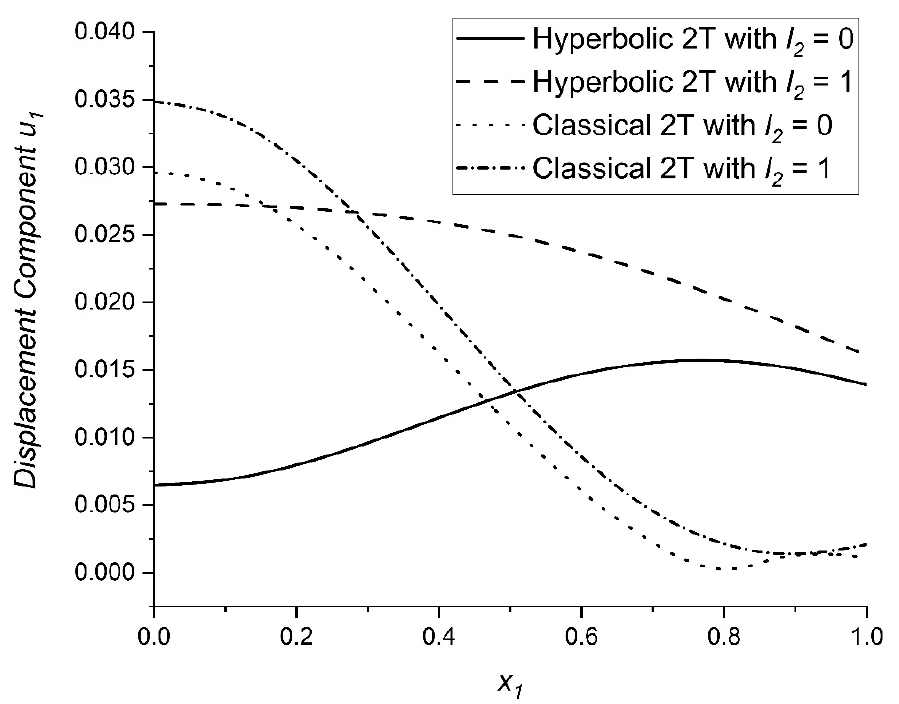
Figure 3. Variations in dimensionless displacement component 𝑢 (cid:2869) .